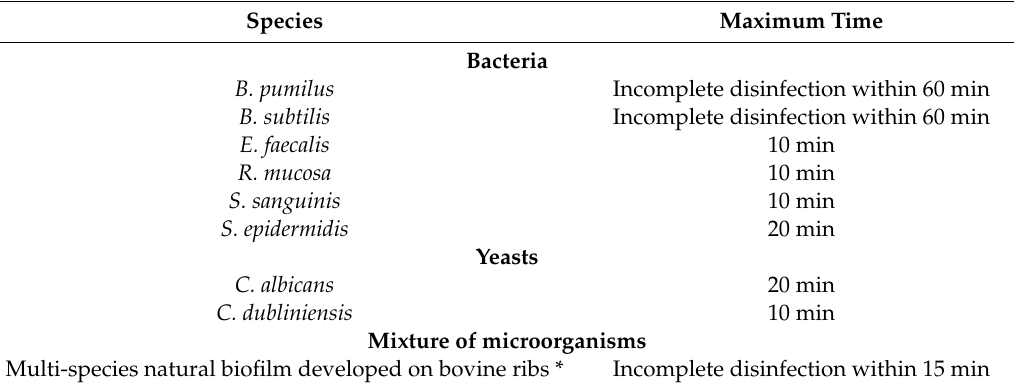
Table 3. Time for disinfection of implants placed in silicone depending on biofilm-forming species. All experiments were carried out in three independent biological replicates ( n = 3) and the longest necessary treatment time is given. Implants were pre-incubated with the respective microorganisms to allow biofilm formation for three to five